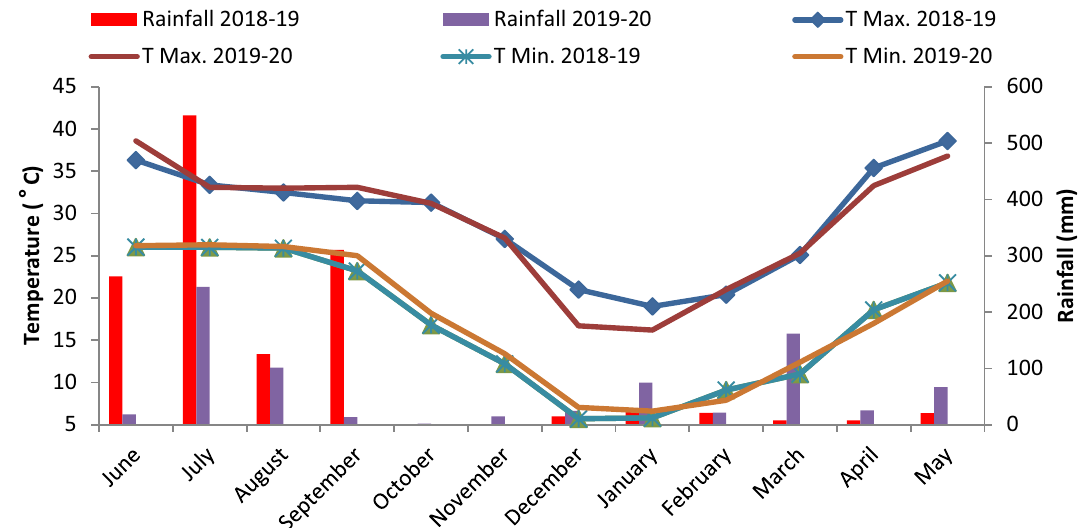
Figure 1. Yearly weather data of rainfall and temperature (max. and min.) for the year 2018–19 and